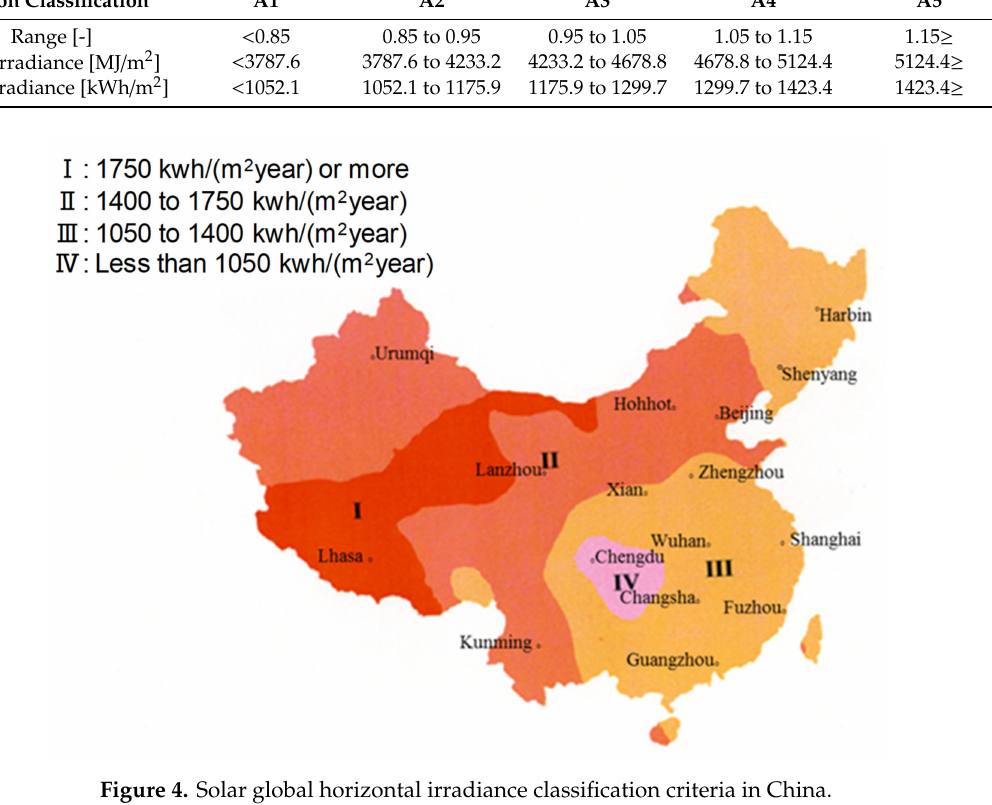
Figure 4. Solar global horizontal irradiance classification criteria in China. Table 12. Solar global horizontal irradiance classification in East Asia.